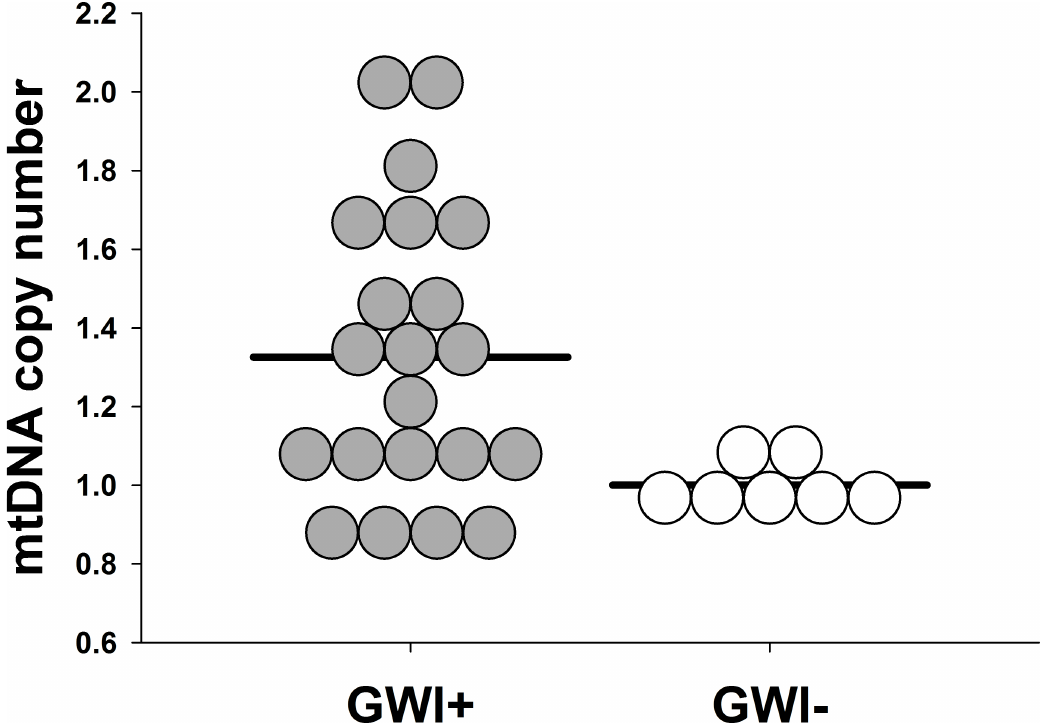
Fig 2. Mitochondrial content identified by QPCR analysis of blood for cases with (n = 21, GWI+) and without (n = 7, GWI-) Gulf War illness. Dot density plot data represent mitochondrial content, as indexedby mtDNA copy number, in GWI+ cases and controls (GWI-). Greater mtDNA copy numberwas observed amongcases with GWI + relativeto controls ( p = 0.001, d = 1.69). Fig 2), and nuclear DNA lesions (0.06 ± 0.17 vs. 0.01 ± 0.11 lesions/10kb, p = 0.344, d =